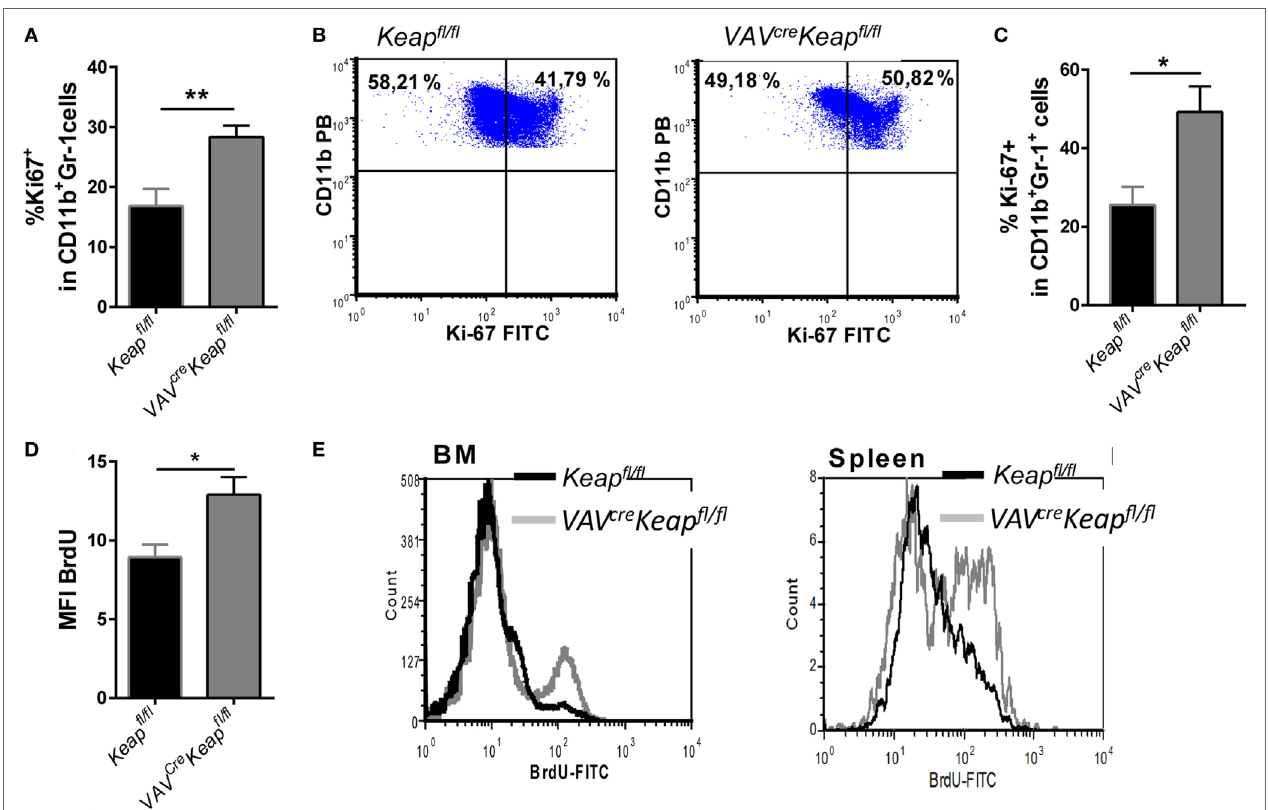
FigUre 4 | Nrf2 induces proliferation of myeloid-derived suppressor cells (MDSCs). (a) Statistical analysis of Ki-67 expression in pre-gated splenic CD11b + Gr-1 + Keap fl/fl ( n = 5) and VAV cre Keap fl/fl ( n = 5) cells. Bars indicate mean of mean fluorescence intensity and error bars SEM. (B) Representative dot plots showing Ki-67 expression in pre-gated CD11b + Gr-1 + BM-derived cells. (c) BM-derived cells were incubated with GM-CSF and IL-6 for 8 days and frequencies of Ki-67 + cells within CD11b + Gr-1 + cells were assessed by flow cytometry. Bars indicate mean ± SEM of four independently performed experiments. (D) Keap fl/fl and VAV cre Keap fl/fl mice were fed orally with BrdU for 14 days. Statistical analysis of BrdU incorporation among pre-gated CD11b + Gr-1 cells of Keap fl/fl ( n = 5) and VAV cre Keap fl/fl ( n = 6) mice. (e) Representative histogram shows overlays of BrdU incorporation in pre-gated CD11b + Gr-1 + cells of spleen and BM. Two-tailed unpaired t -tests were used to determine p -values for all statistical